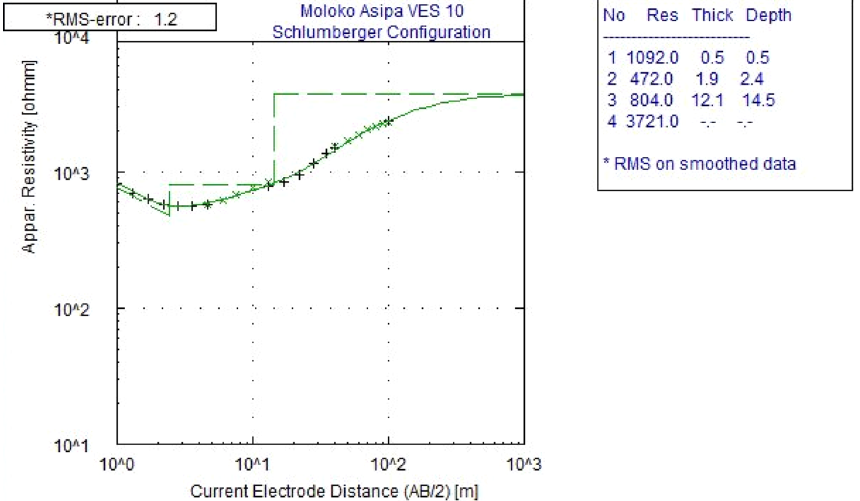
Fig. 19 Layer model interpreta- tion for VES